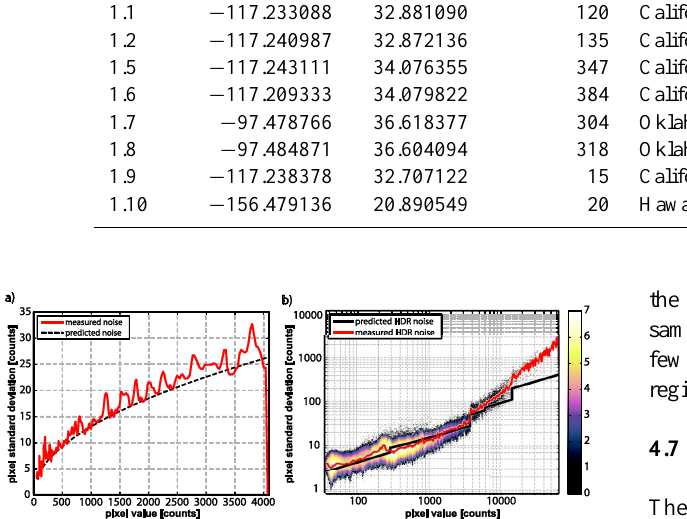
Table 3. USI Locations in the United States and deployment time ranges. USI no.